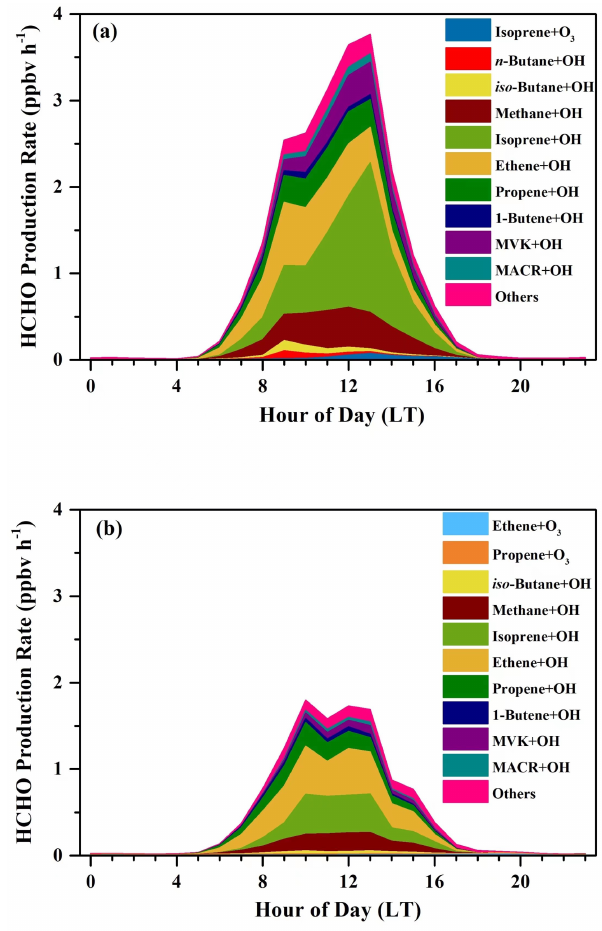
Figure 8. Average diurnal variations in HCHO production rates (ppbvh − 1 ) from the OH-initiated and O 3 -initiated oxidation dur- ing (a) the sunny period and (b) the cloudy and rainy period.